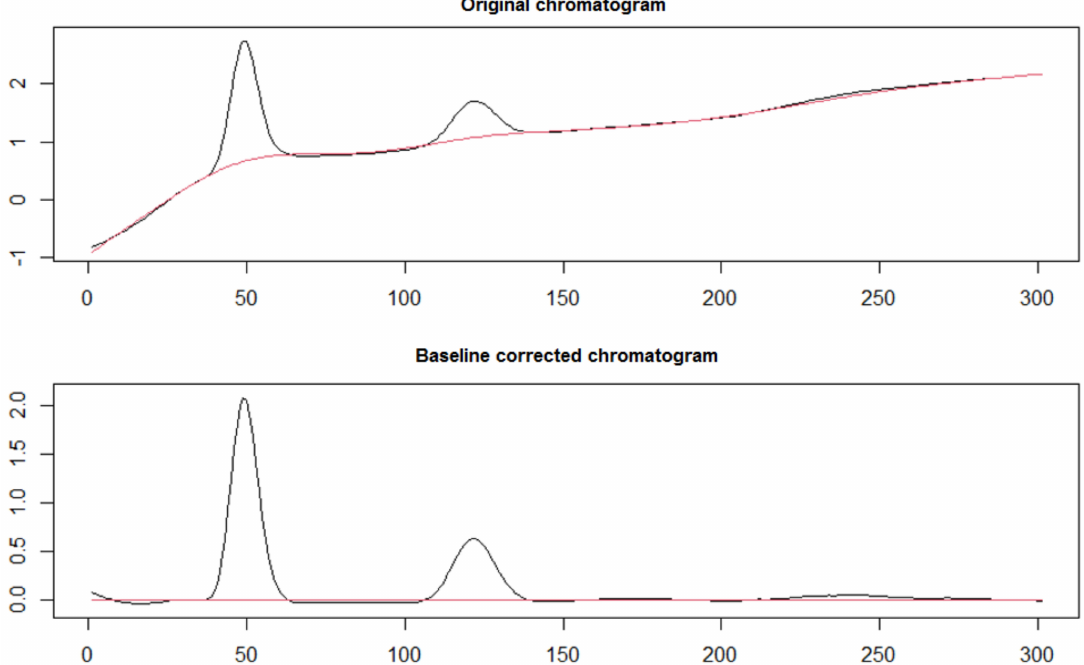
Figure 3. Original chromatogram and baseline corrected chromatogram after applying the ALS algorithm from the “baseline” package in